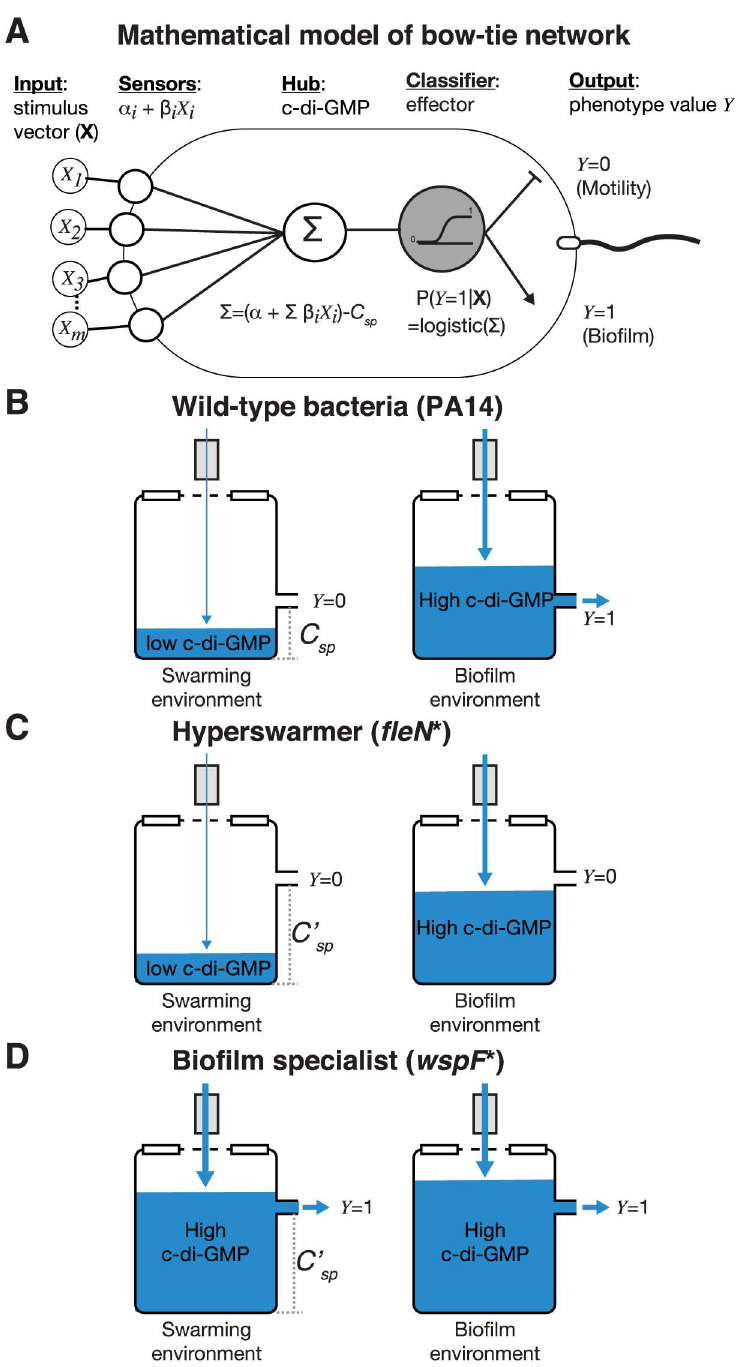
Fig 3. Bow-tie model of biochemical reactions in the c-di-GMP network explains mutants of PA14 evolved in the laboratory. A: Diagramof the bow-tie model showingthe α and β coefficientsfor sensor and effector modules.B-D: A water tank diagram explainshow the relativevalues of c-di-GMP and the effector setpoint lead to the specialistphenotypes for mutants (C,D) evolvedfrom a generalistlaboratory strain (PA14) in laboratoryexperiments